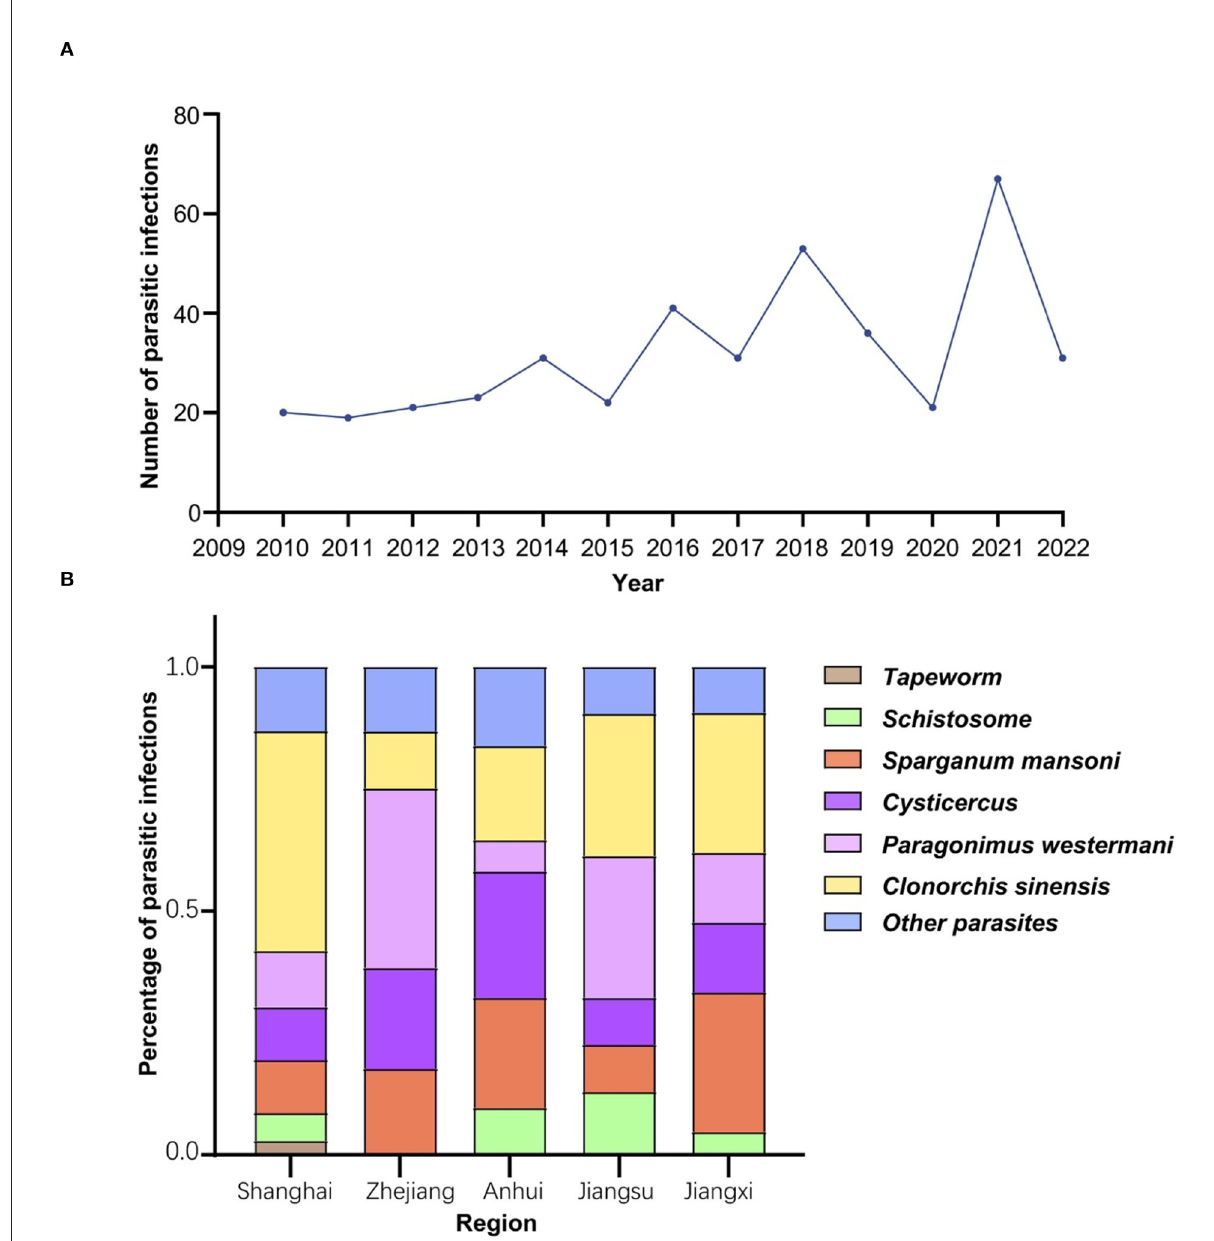
FIGURE2 Epidemiological characteristics of parasitic diseases. (A) Parasitic infections in Ruijin hospital over the recent 13 years. The prevalence of parasitic infection showed an upward trend of waves with a peak in 2021. (B) The prevalence of the most common six parasites in five main regions of origin. Parasite-infected patients admitted to Shanghai Ruijin Hospital were mainly from Shanghai, Zhejiang, Anhui, Jiangsu, Jiangxi. Clonorchis sinensis was the most common parasite found in patients from Shanghai, while Paragonimus westermani was the most common one identified in patients from Zhejiang and